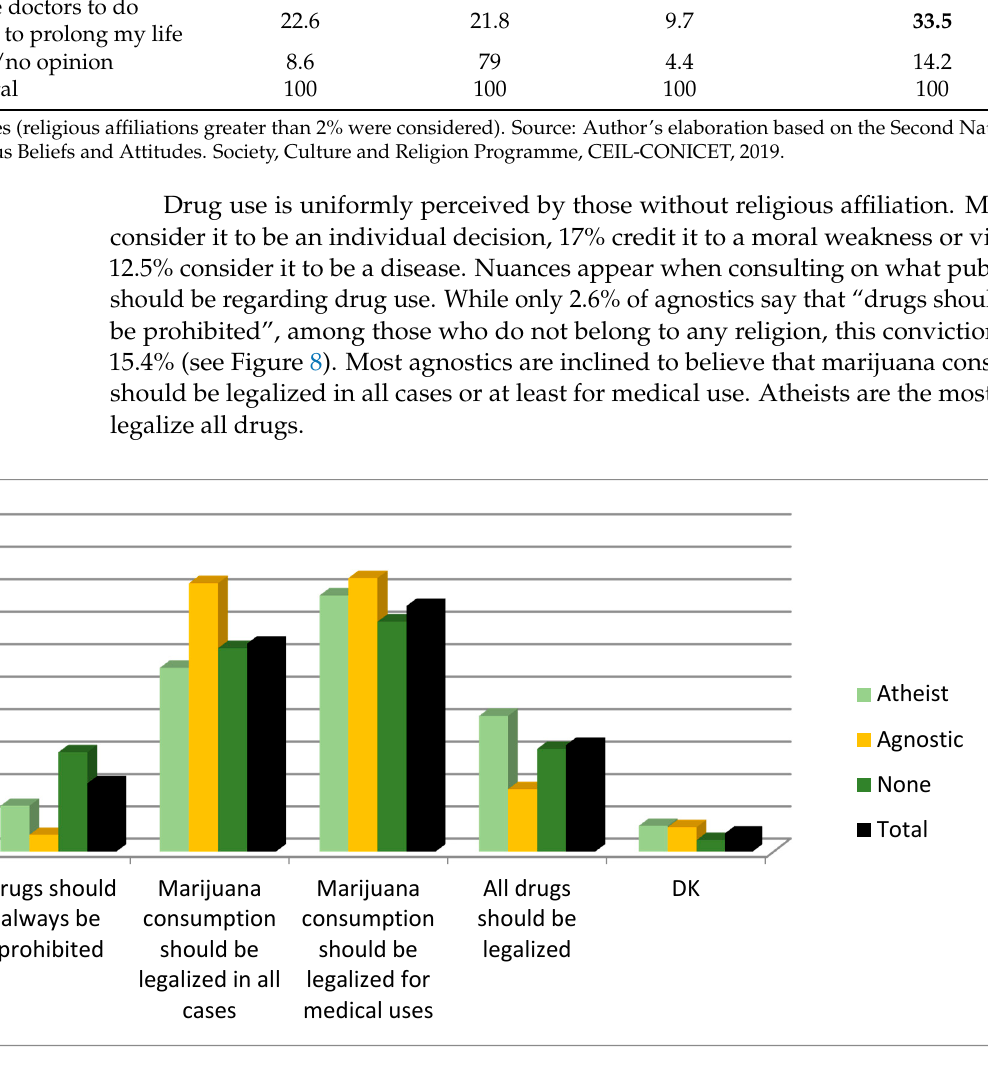
Figure 8. Opinion on drugs legalization (in %). Based on 382 cases. Source: Author’s elaboration based on the Second National Survey on Religious Beliefs and Attitudes. Society, Culture and Religion Program, CEIL-CONICET, 2019.